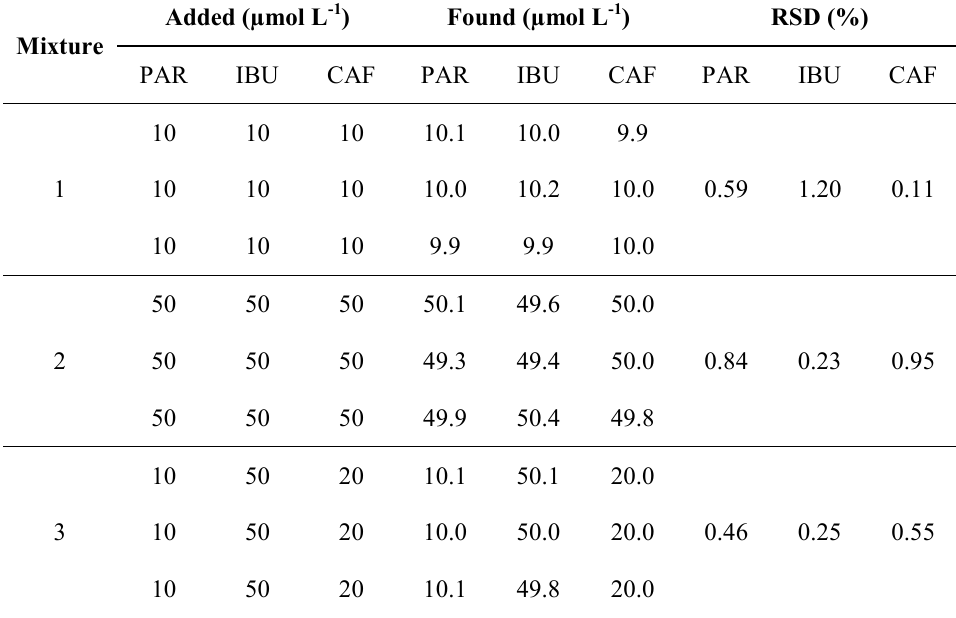
Figure 7: First-derivative ratio spectra for a ternary mixture of paracetamol, caffeine and ibuprofen in 10 µmol L-1 after simultaneous standard addition of components in the concentration range of 10-60 µmol L-1. Conditions: double divisors (PAR, 10 µmol L- 1+IBU, 10 µmol L- -R buffer pH 11.0. Table 1. Replicative determination of paracetamol, ibuprofen and caffeine in some ternary mixtures by combination of double-divisor ratio spectra derivative method and